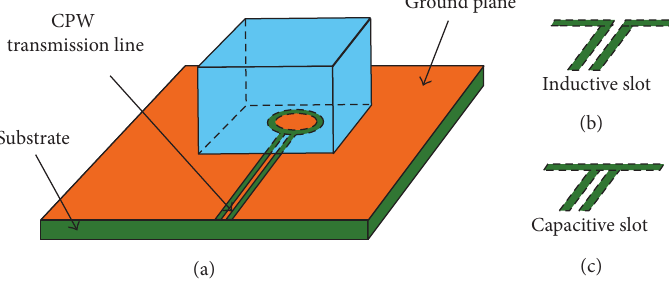
Figure 11: Rectangular DRA fed by a CPW circular-loop network (a). Inductive slot feed (b). Capacitive slot feed (c).